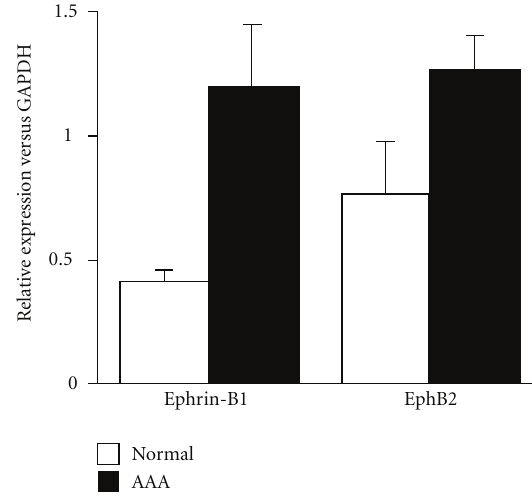
Figure 1: Quantitative real-time RT-PCR analysis of ephrin-B1 and EphB2 in human AAA. The results are mean ± SEM ( n = 10) and were analysed by an unpaired Student’s t